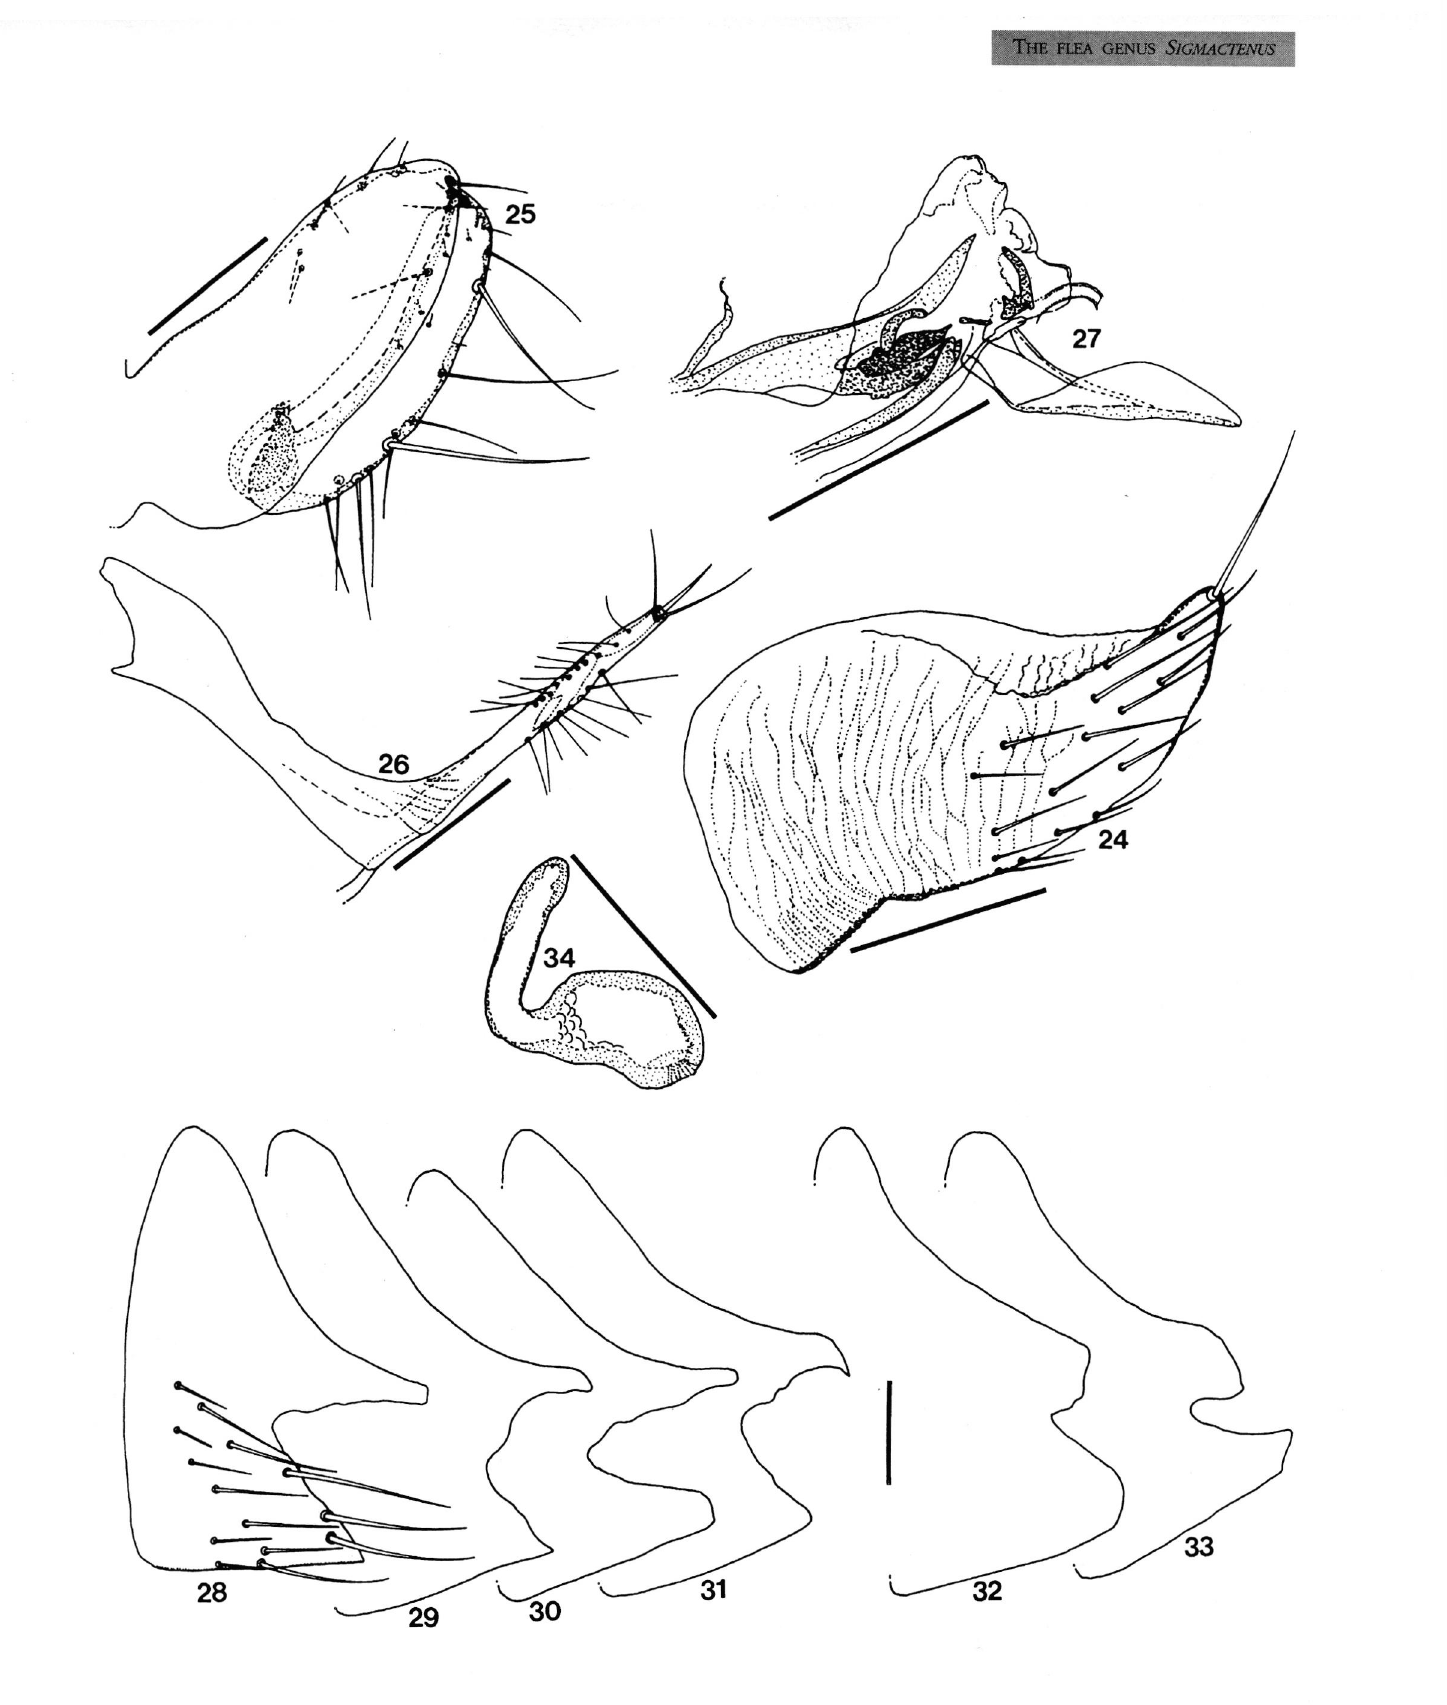
Figs 24-34. - Sigmactenus alticola crassinavis n. ssp. and S. a. alticloa. 24: S. a. crassinavis, Sternite VIII of male (holotype). 25: S. a. cras sinavis, Tergite IX of male (holotype). 26: S. a. crassinavis, Sternite IX of male (holotype). 27: S. a. crassinavis, Phallosome (aedeagus) of male (holotype). 28-31: S. a. crassinavis, Sternite VII of female showing variation (28: allotype, 29 -31: paratypes). 32, 33: S. a. alticola, Sternite VII of females (topotypes) showing variation. 34: S. a. crassinavis, Spermatheca of female (paratype). All scale bars = 0,1